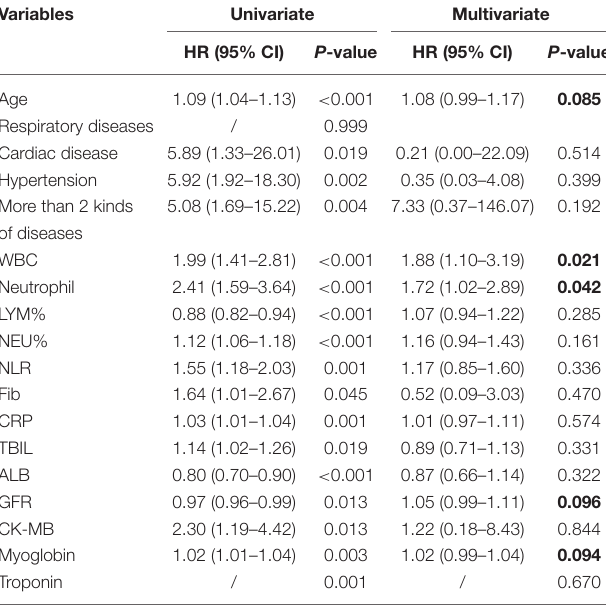
TABLE 2 | Predictive factors for the severity of COVID-19 by Logistic Regression Model.